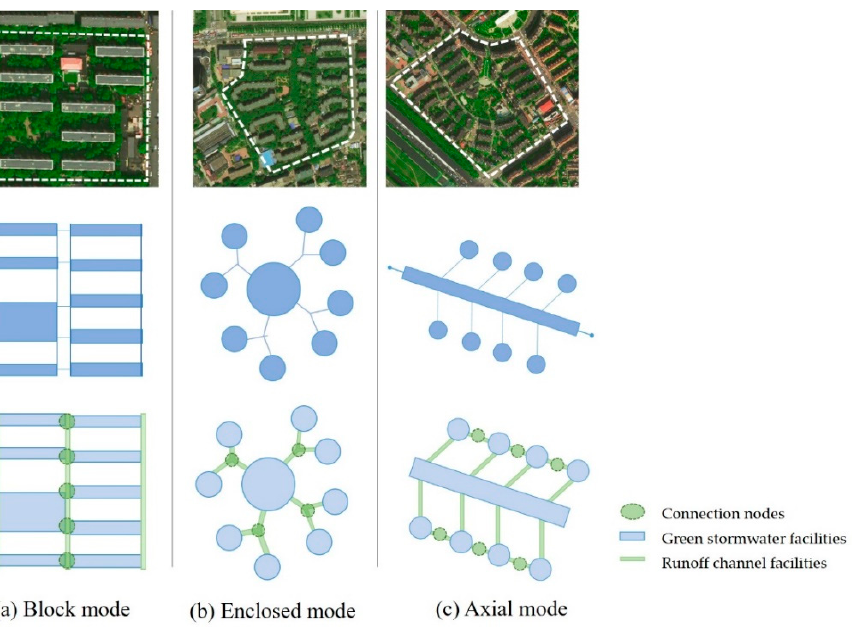
Figure 11. Optimization strategies for green space placement for block mode, enclosed mode, and axial mode.